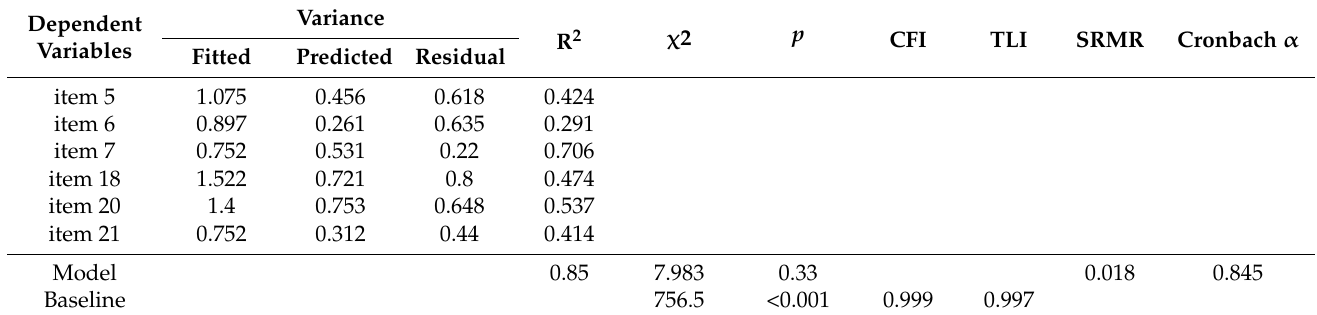
Table 1. CFA fit